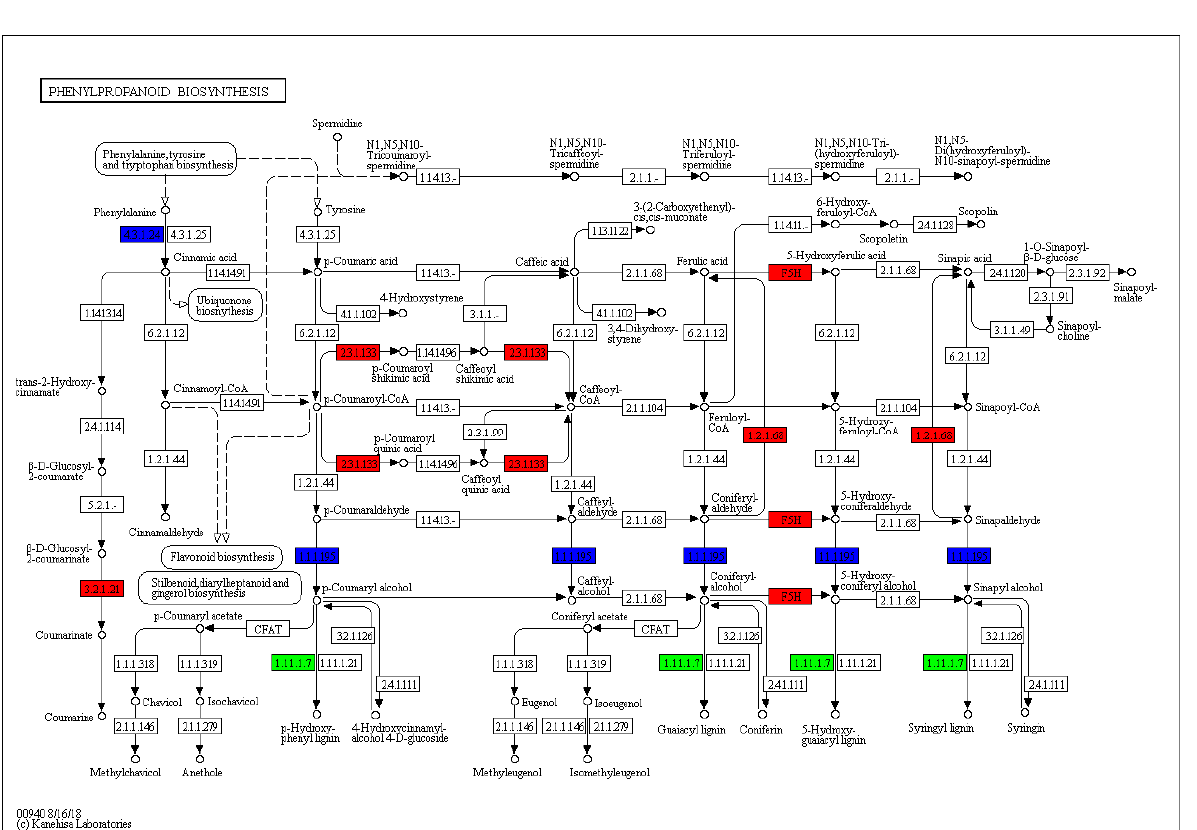
Figure 2. Phenylpropanoid biosynthesis pathway enriched by a post-harvest cold treatment in strawberry fruits. The enriched KEGG pathways are illustrated with copyright permission. Genes in red are upregulated, those in blue are downregulated, and those in green are either upregulated or downregulated.